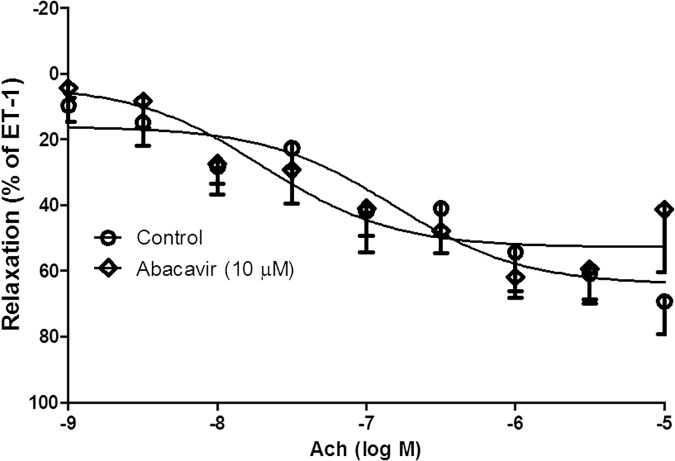
Effects of short-term treatment with abacavir on acetylcholine-induced relaxation of rat basilar arteries.Basilar arterial rings were treated with abacavir (10 μM) for 24 h. Rings not treated with abacavir served as controls. Acetylcholine (Ach)-induced relaxation of basilar arteries was then measured. Changes in tension were expressed as a percentage decrease in response to contraction caused by endothelin-1 (ET-1 1–10 nM). Values are means ± S.E.M. of five to eight sets of experiments and statistical comparisons were made using ANOVA.